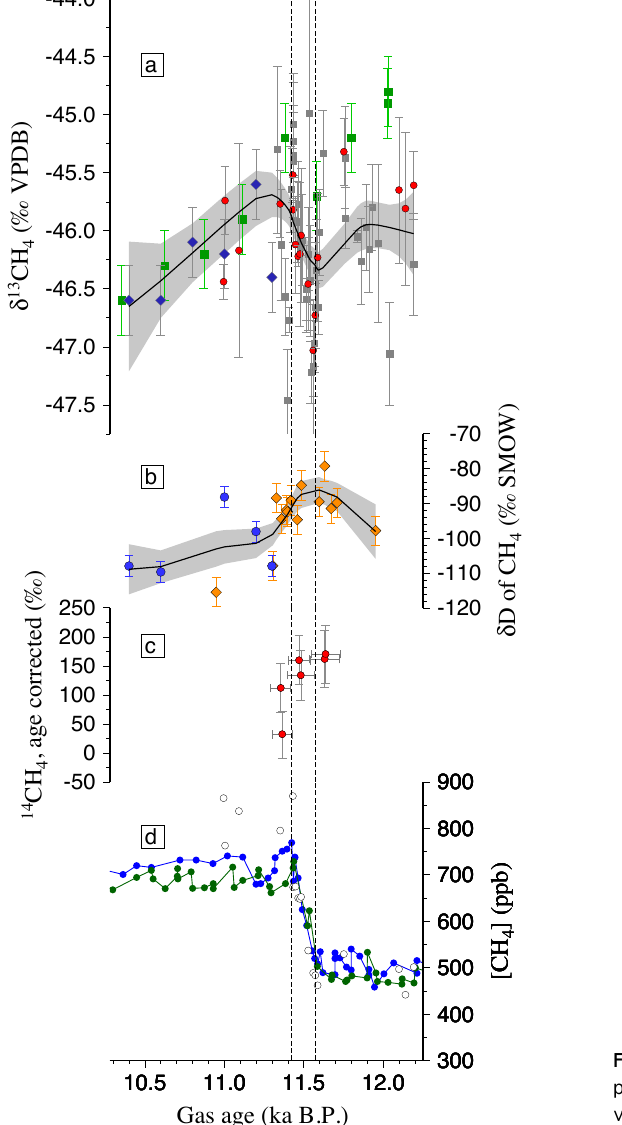
Fig. 2. The Younger Dryas to Preboreal δ 13 CH 4 , δ D-CH 4 , 14 CH 4 , and [CH 4 ] records. (A) P˚akitsoq, Greenland δ 13 CH 4 records from this study [circles] and Schaefer et al. (2006) [grey squares] (Schae- fer et al., 2006), GISP2 [blue diamonds] (Sowers, 2010), and EPICA EDML [green squares] (Fischer et al., 2008). A weighted loess spline fit to the Greenland data (P˚akitsoq and GISP2, shaded region is a 1 σ standard error envelope, span 0.75) shows the general trends although it dampens the larger changes in the isotope record. (B) The δ D-CH 4 record from GISP2 [circles (Sowers, 2010) and diamonds (Sowers, 2006)] with a weighted loess spline (span 0.75). (C) The 14 CH 4 record from P˚akitsoq, Greenland (cosmogenic 14 C- corrected values) (Petrenko et al., 2009). (D) [CH 4 ] records from GISP2 [blue] (Brook et al., 2000), EDML [green] (EPICA Com- munity Members, 2006), and P˚akitsoq IRMS [open circles]. The latter record has lower precision. All data are shown using the re- vised Pak06 age scale (Sect. 2.2.5). The vertical dashed lines show the YD-PB limits.